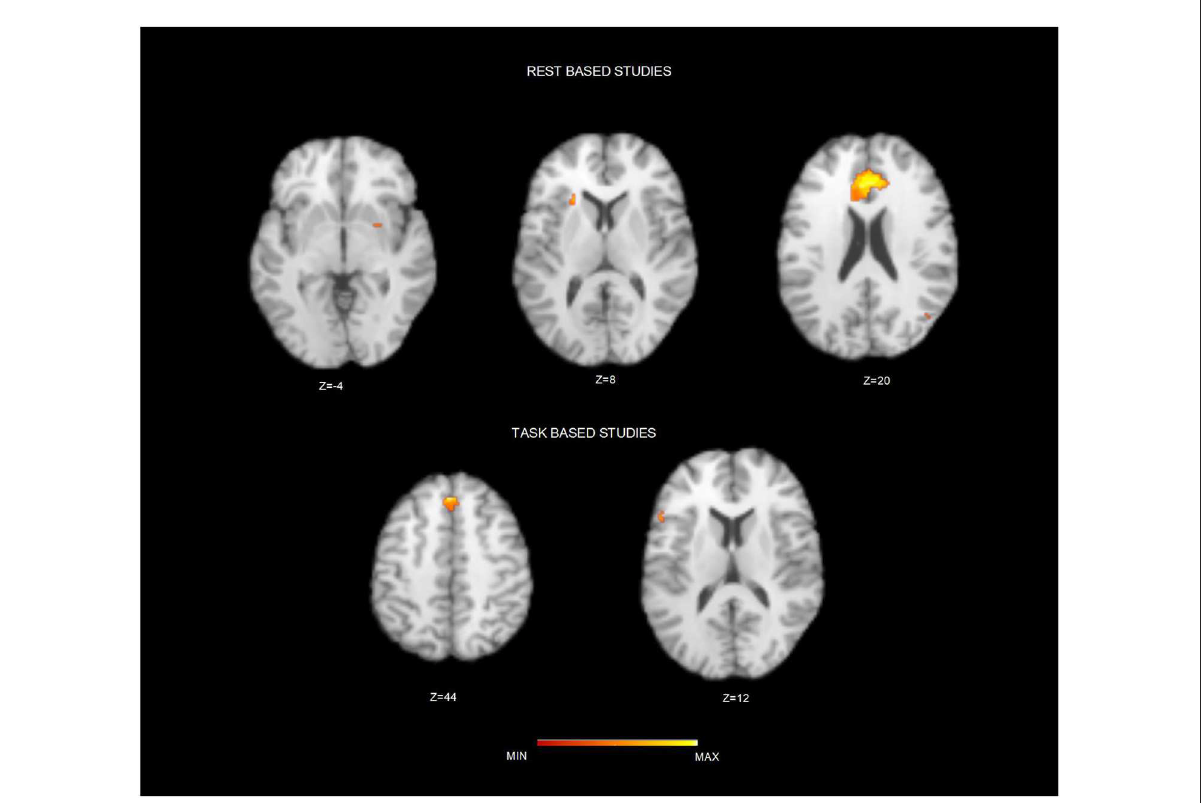
FIGURE2 Brain clusters resulting from the conjunction analysis between resting state and task based studies. Figure depicts the resulting brain cluster after applying the conjunction analysis between resting state (Top) and task-based studies (Down) . Maps are over imposed on a Talairach template in the axial plane and in neurological